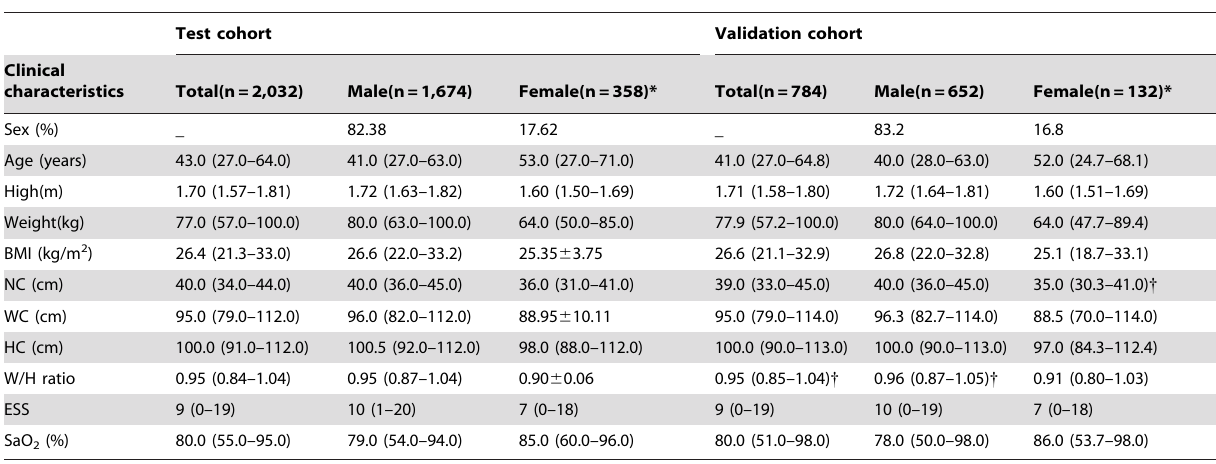
Table 1. Clinical characteristics of the